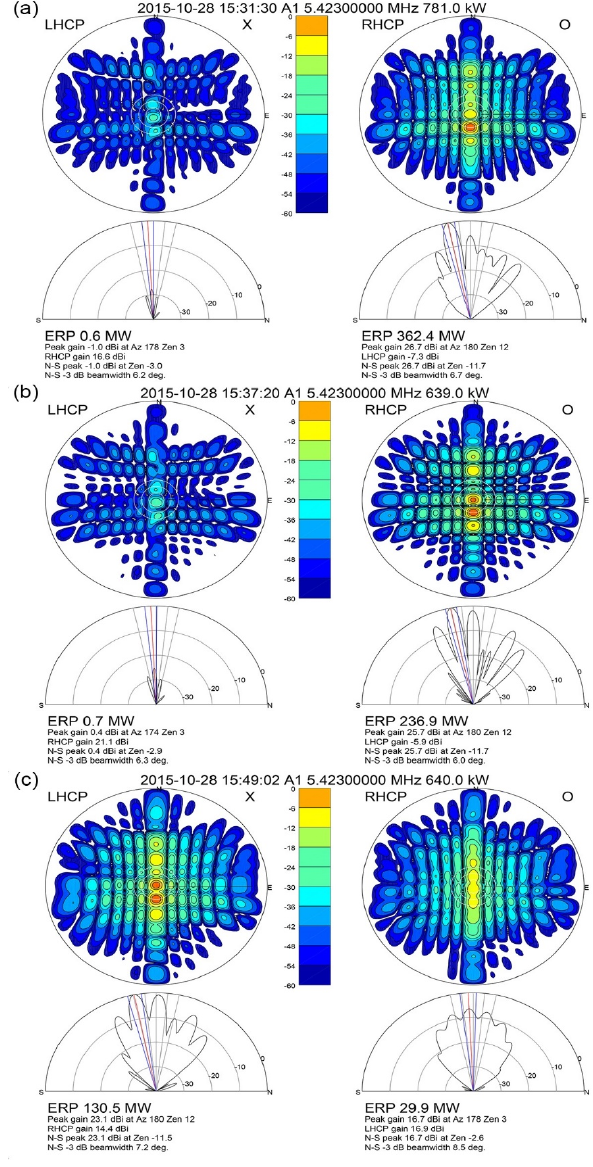
Figure 1. Calculated effective radiated power ( ERP ) and beam patterns of the extraordinary (X) and ordinary (O) HF pump waves on 28 October 2015at ( a ) 15:31:30 UT, ( b ) 15:37:20 UT, and ( c ) 15:49:20 UT (calculations have been performed by M.T. Rietveld).